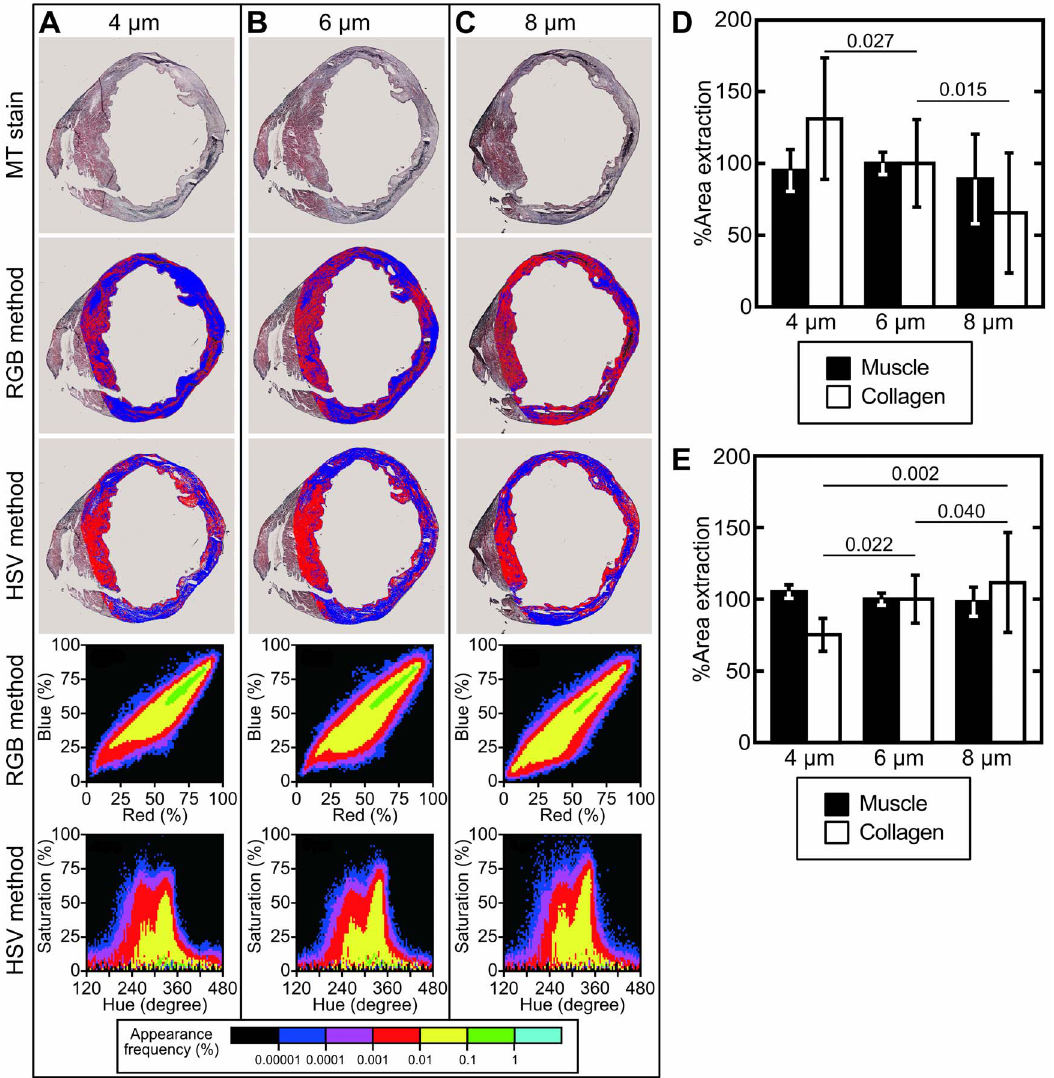
Figure 2. Analytic performance across diverse section thicknesses. A) A section of infarcted mouse heart cut to 4 m m and stained with Masson’s trichrome. Descending from the original image, we see the RGB binary image, the HSV binary image, a density map of the pixels mapped to the RGB color space, and a density map of the pixels mapped to the HSV color space. B) A section of infarcted mouse heart cut to 6 m m and stained with Masson’s trichrome. C) A section of infarcted mouse heart cut to 8 m m and stained with Masson’s trichrome. D) For each of four experimental hearts and each of the three section thicknesses, the area identified as muscle is plotted next to the area identified as collagen using the RGB method. Because each heart has a different size infarction, these results for each heart are normalized as a percentage of the measured area in the 6 m m sample. As the section thickness increases, RGB analysis decreases the perceived collagen area, despite analyzing adjacent sections of heart. E) For each of four experimental hearts and each of the three section thicknesses, the area identified as muscle is plotted next to the area identified as collagen using the HSV method. Because each heart has a different size infarction, these results for each heart are normalized as a percentage of the measured area in the 6 m m sample. There is no discernible change in perceived muscle or collagen area as the section thickness increases when using the HSV method. displays this number as both a scalar and as a percentage of the region of interest (ROI).